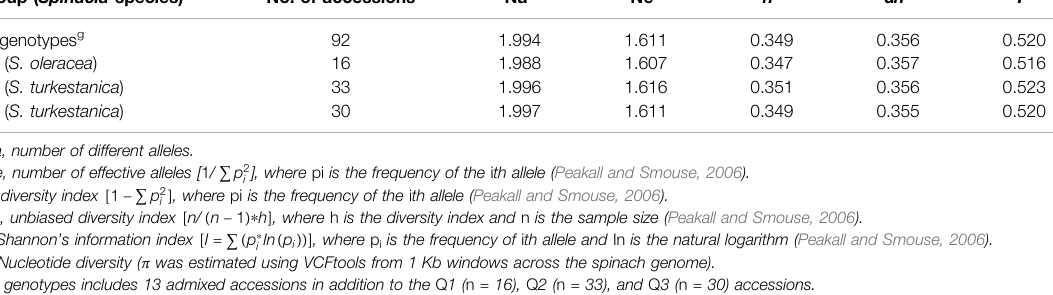
TABLE 3 | Mean number of different alleles (Na), number of effective alleles (Ne), diversity index ( h ), unbiased diversity index (u h ), Shannon ’ s information index ( I ), and nucleotide diversity ( π ) calculated for 7,065 single nucleotide polymorphisms (SNPs) common to 92 Spinacia accessions. Group ( Spinacia